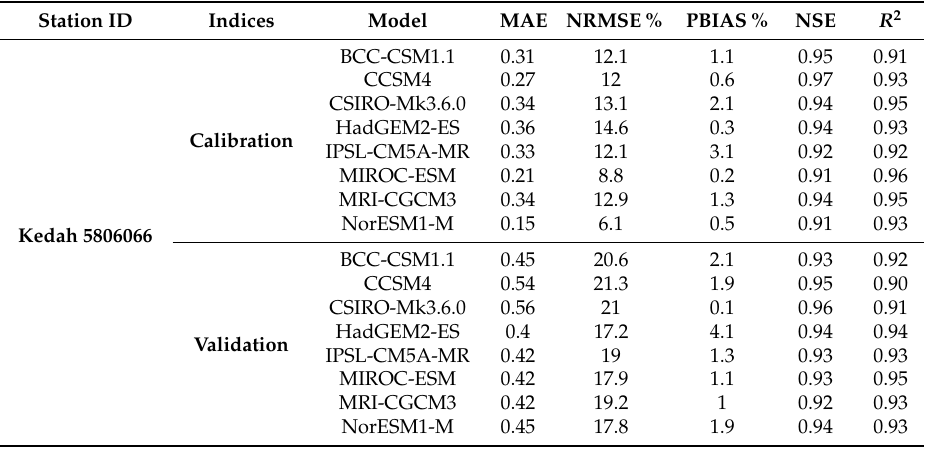
Figure 4. Downscaled and observed rainfalls for various GCMs at station Kedah. Table 5. Calibration and validation of downscaling model for various GCMs at station